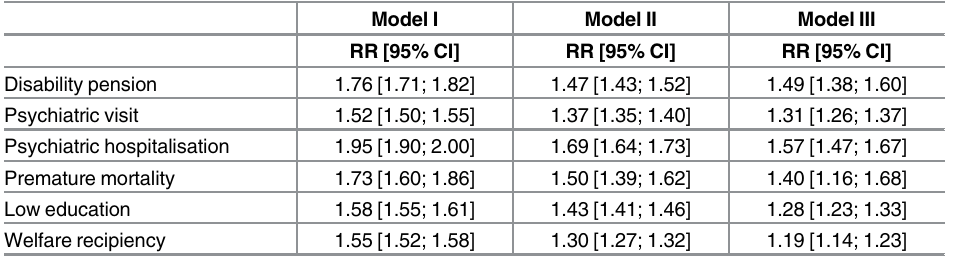
Table 2. Relative risks (RR) and corresponding 95% confidence intervals (CIs) for the associations between TBI before age 25 y and poor functioning in